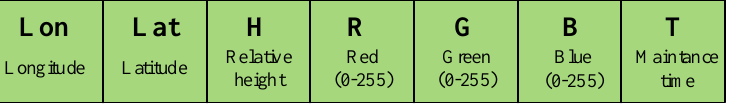
Figure 5. The way-point information